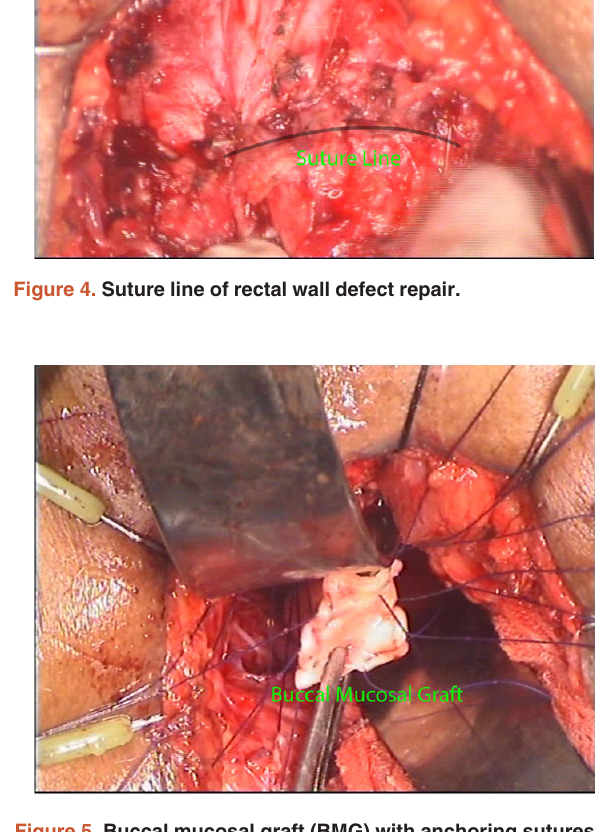
Figure 5. Buccal mucosal graft (BMG) with anchoring sutures.